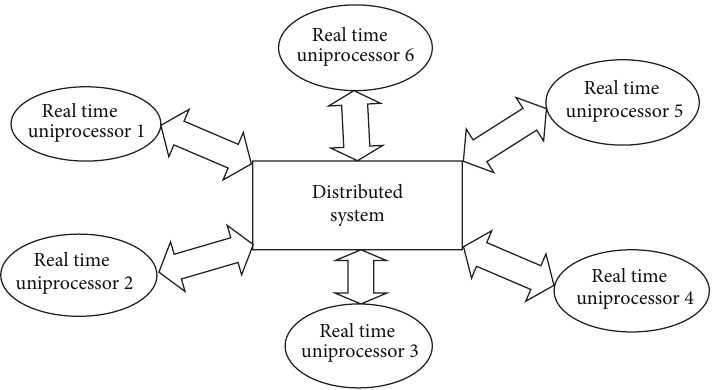
Figure 1: Real time distributed system.